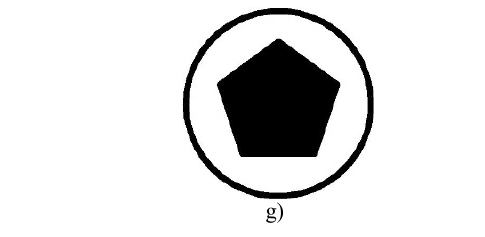
Fig. 1. Standard s crew h ead w rench r ecess p rofiles. a) hexagon; b) torx; c) flat slot; d) cruciform slot; e) triangle; f) square; g) pentagon